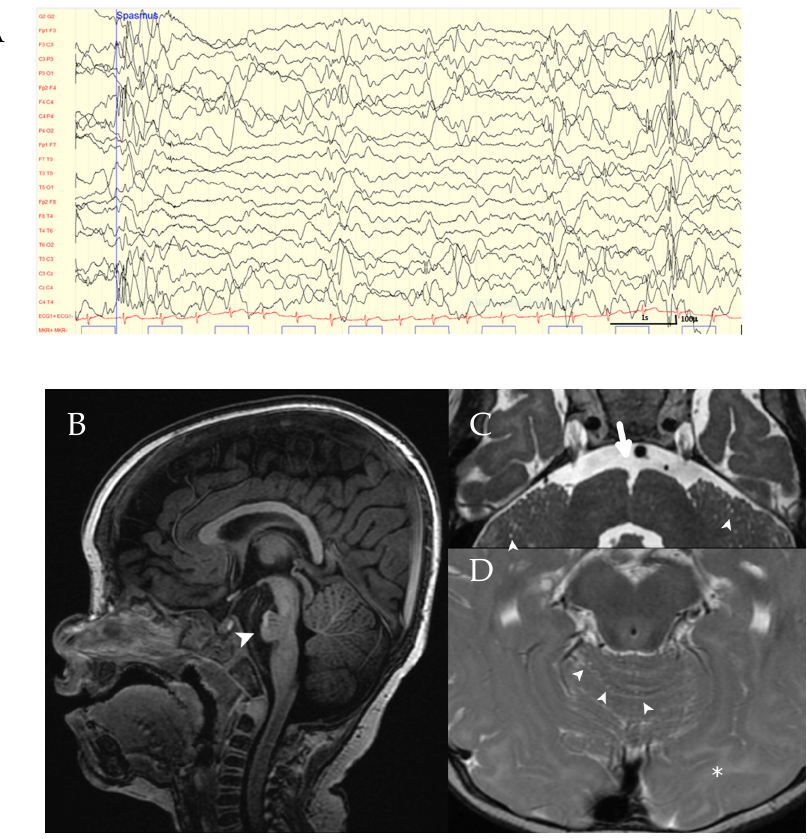
Figure 1. Clinical findings in the index patient. ( A ) EEG of the patient showing generalized epileptiform discharges. ( B – D ) Brain MRI: Sagittal T1-weighted image showing pontine hypoplasia (arrowhead in ( B )). Axial T2-weighted images ( C , D ) demonstrating an abnormally marked anterior median fissure at the pontomedullary junction (large arrow in ( C )), multiple microcysts in the cerebellar hemispheres and cerebellar vermis (arrowheads in ( C , D )), and hyperintense signal of the occipital white matter (asterisk in ( D )).